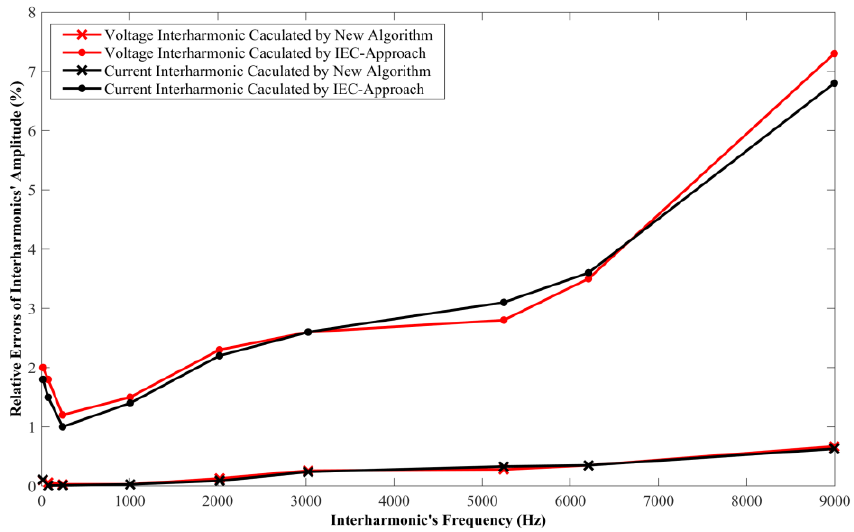
Figure 6. Test results of voltage and current interharmonics’ amplitude.